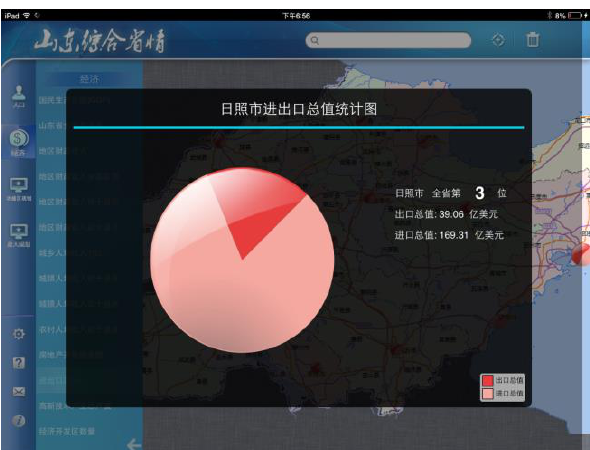
Figure 2. input and export value of 17 cities of Shandong